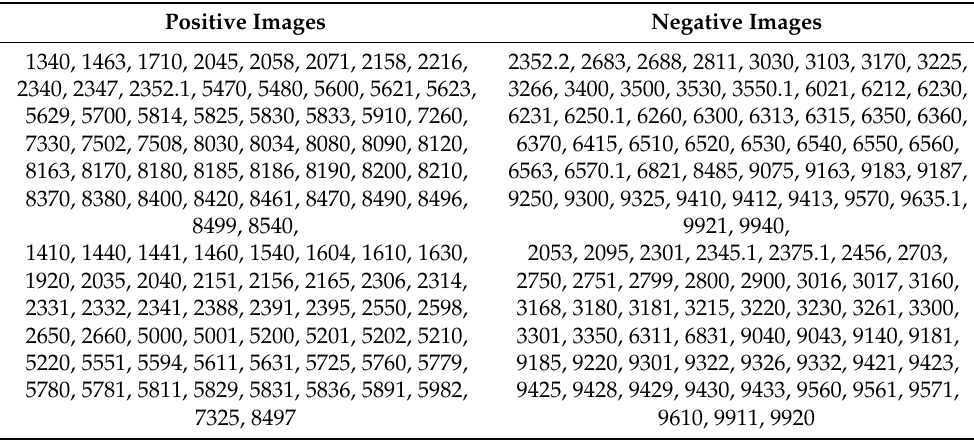
Table 2. IAPS image numbers divided into valance and arousal ratings. Positive